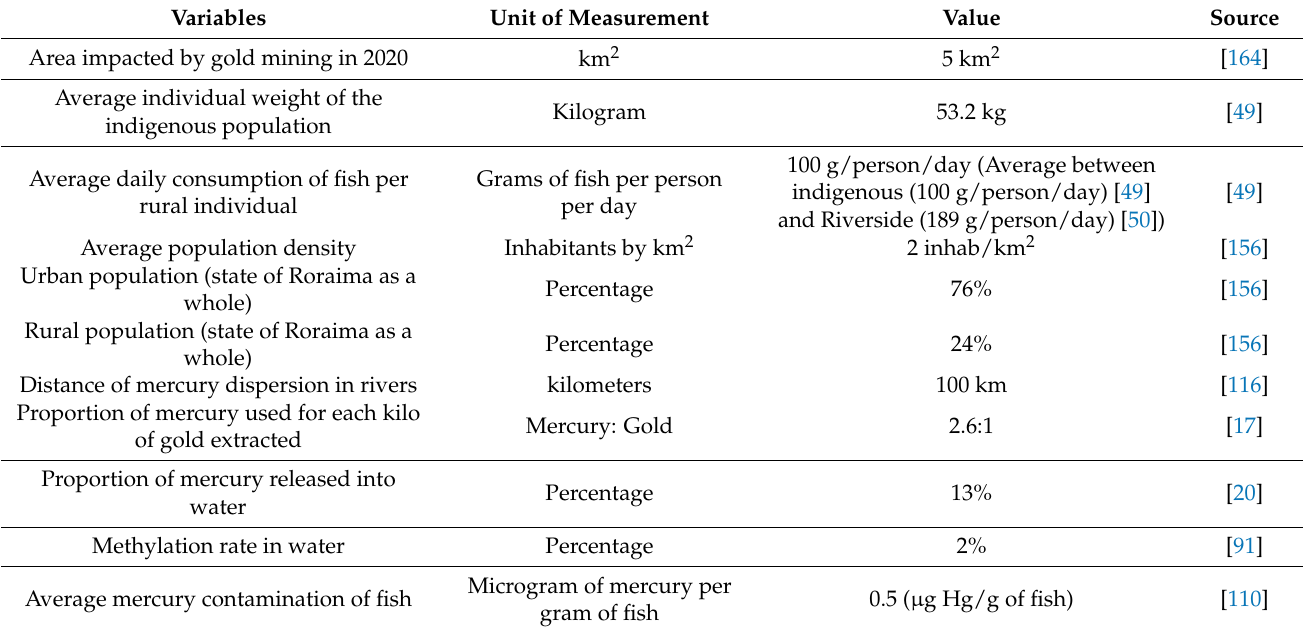
Table 2. Summary of variables, unit of measurement, range values, and source used in Yanomami case study.